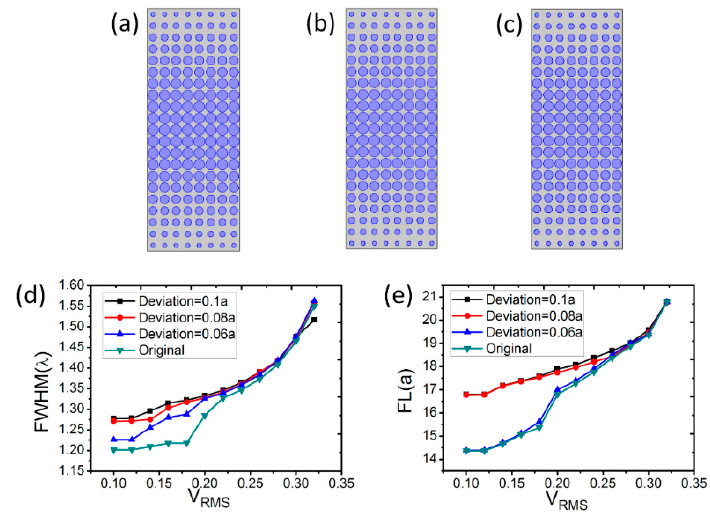
Figure 7. Schematic diagram of a cylindrical radii deviation of ( a ) − 6% ( b ) − 8% ( c ) − 10%. ( d ) The FWHM and ( e ) the FL curves with the RMS voltage variation under different deviations.